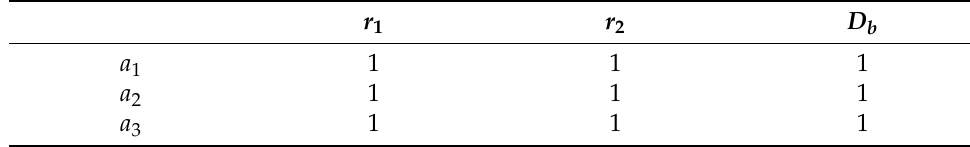
Table 1. Mode change signature